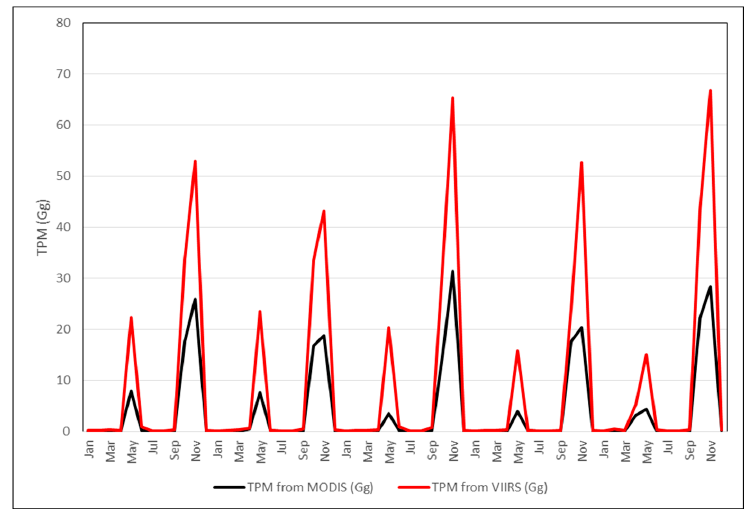
Figure 7. Total Particulate Matter (TPM) emissions in Gg derived from MODIS and VIIRS data.